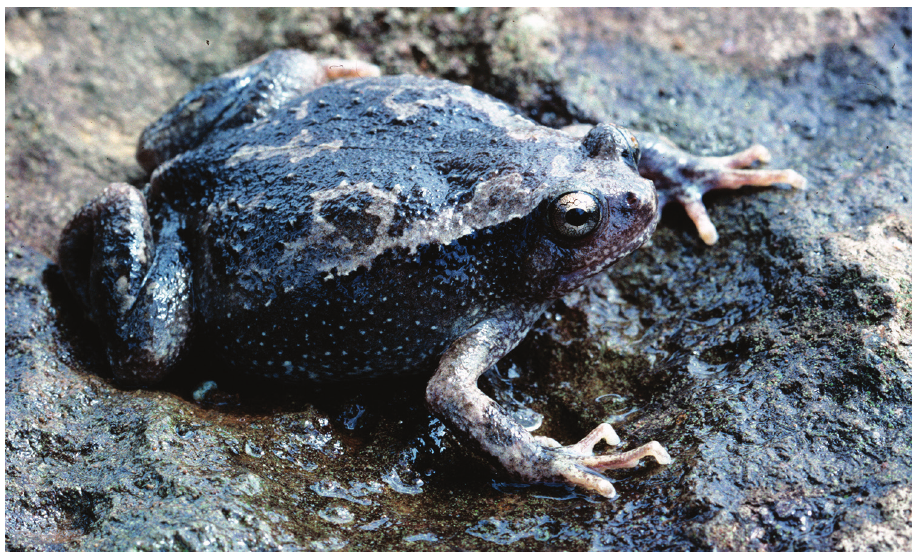
Figure 22. Kaluola picta were observed (specimens not collected) at the Municipality of Gingoog City, Misamis Oriental Province. (TNHC 56371; from Municipality of Toril, Davao City Province). Photo: